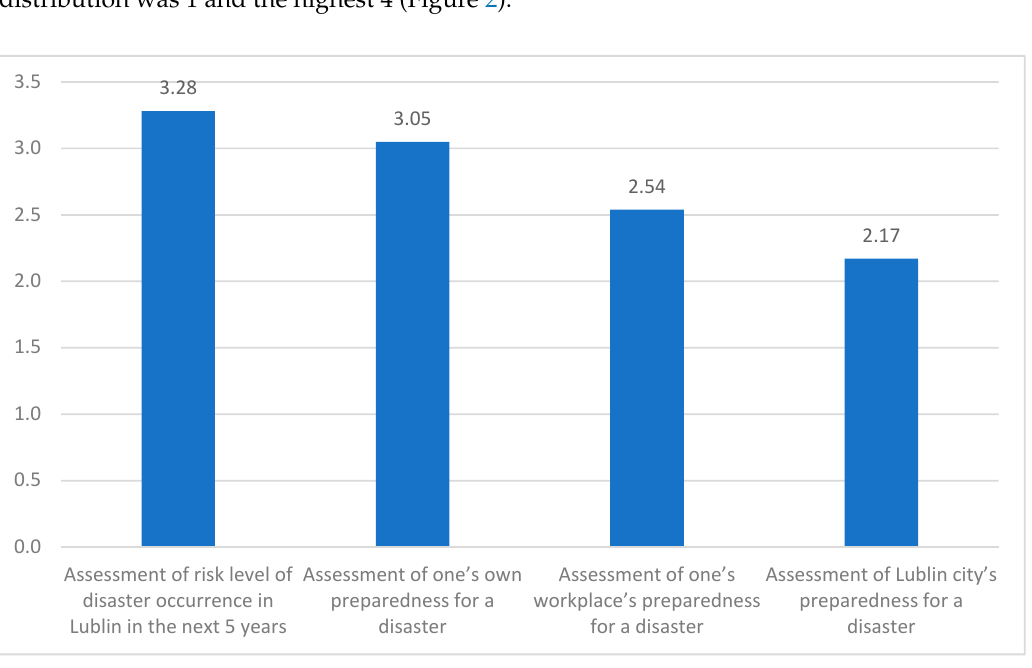
Figure 2. Averages for the assessment of risk level of disaster occurrence and preparedness for disasters. (Y axis = Likert scale from 0–5.).